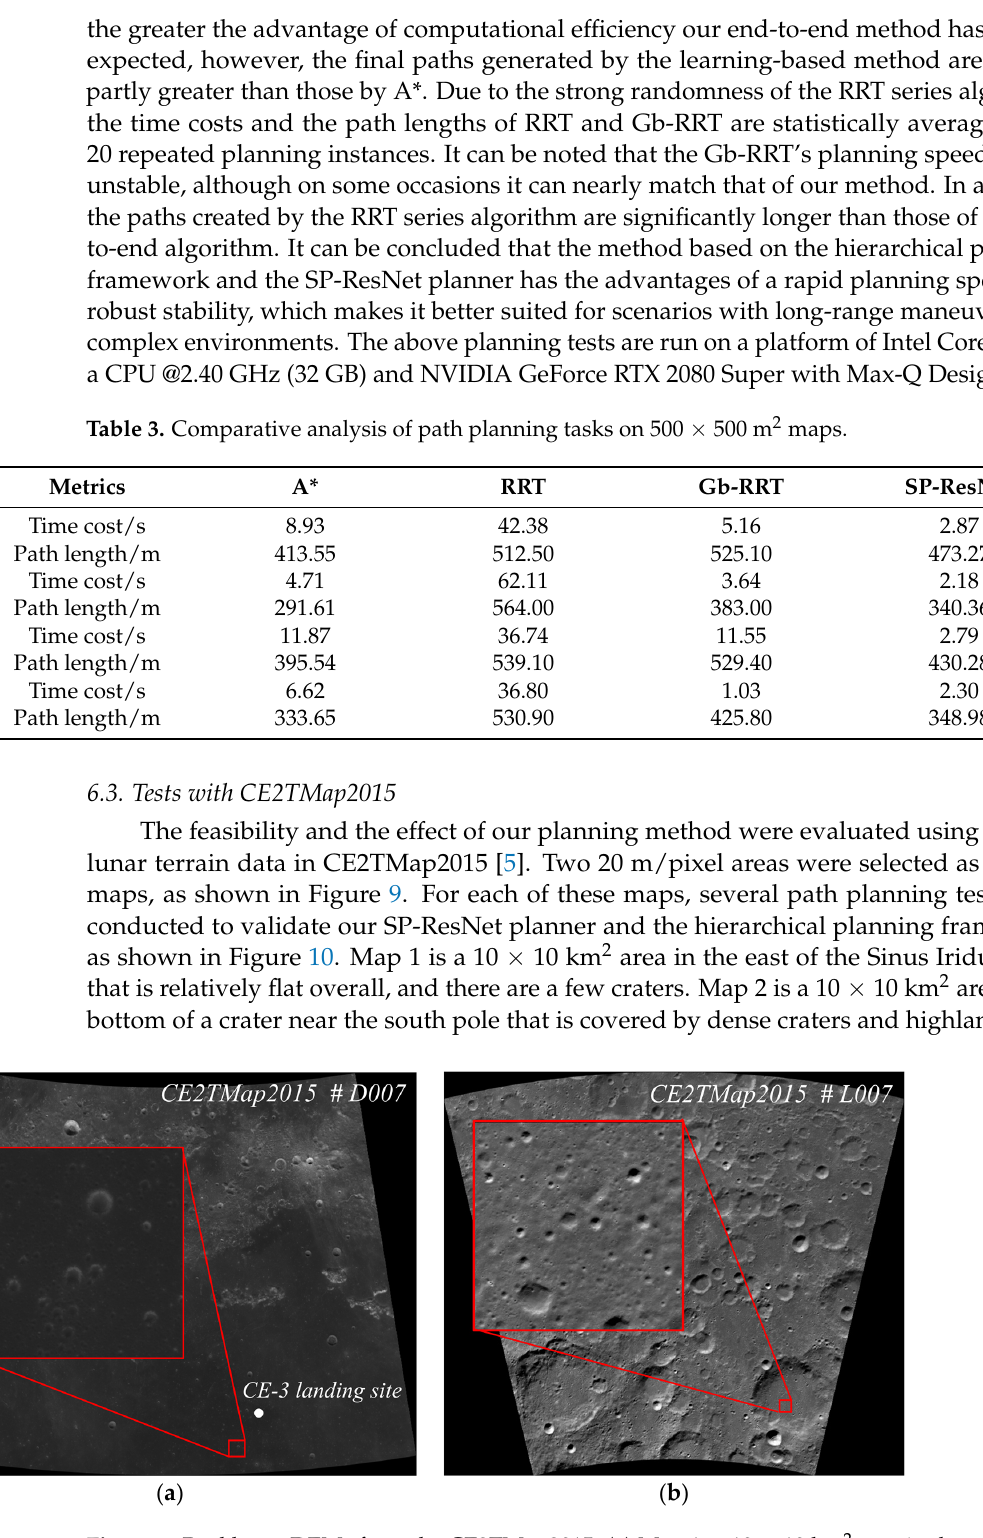
Figure 9. Real lunar DEMs from the CE2TMap2015. ( a ) Map 1: a 10 × 10 km 2 area in the east of the Sinus Iridum area on the Moon. ( b ) Map 2: a 10 × 10 km 2 area at the bottom of a crater near the south pole.